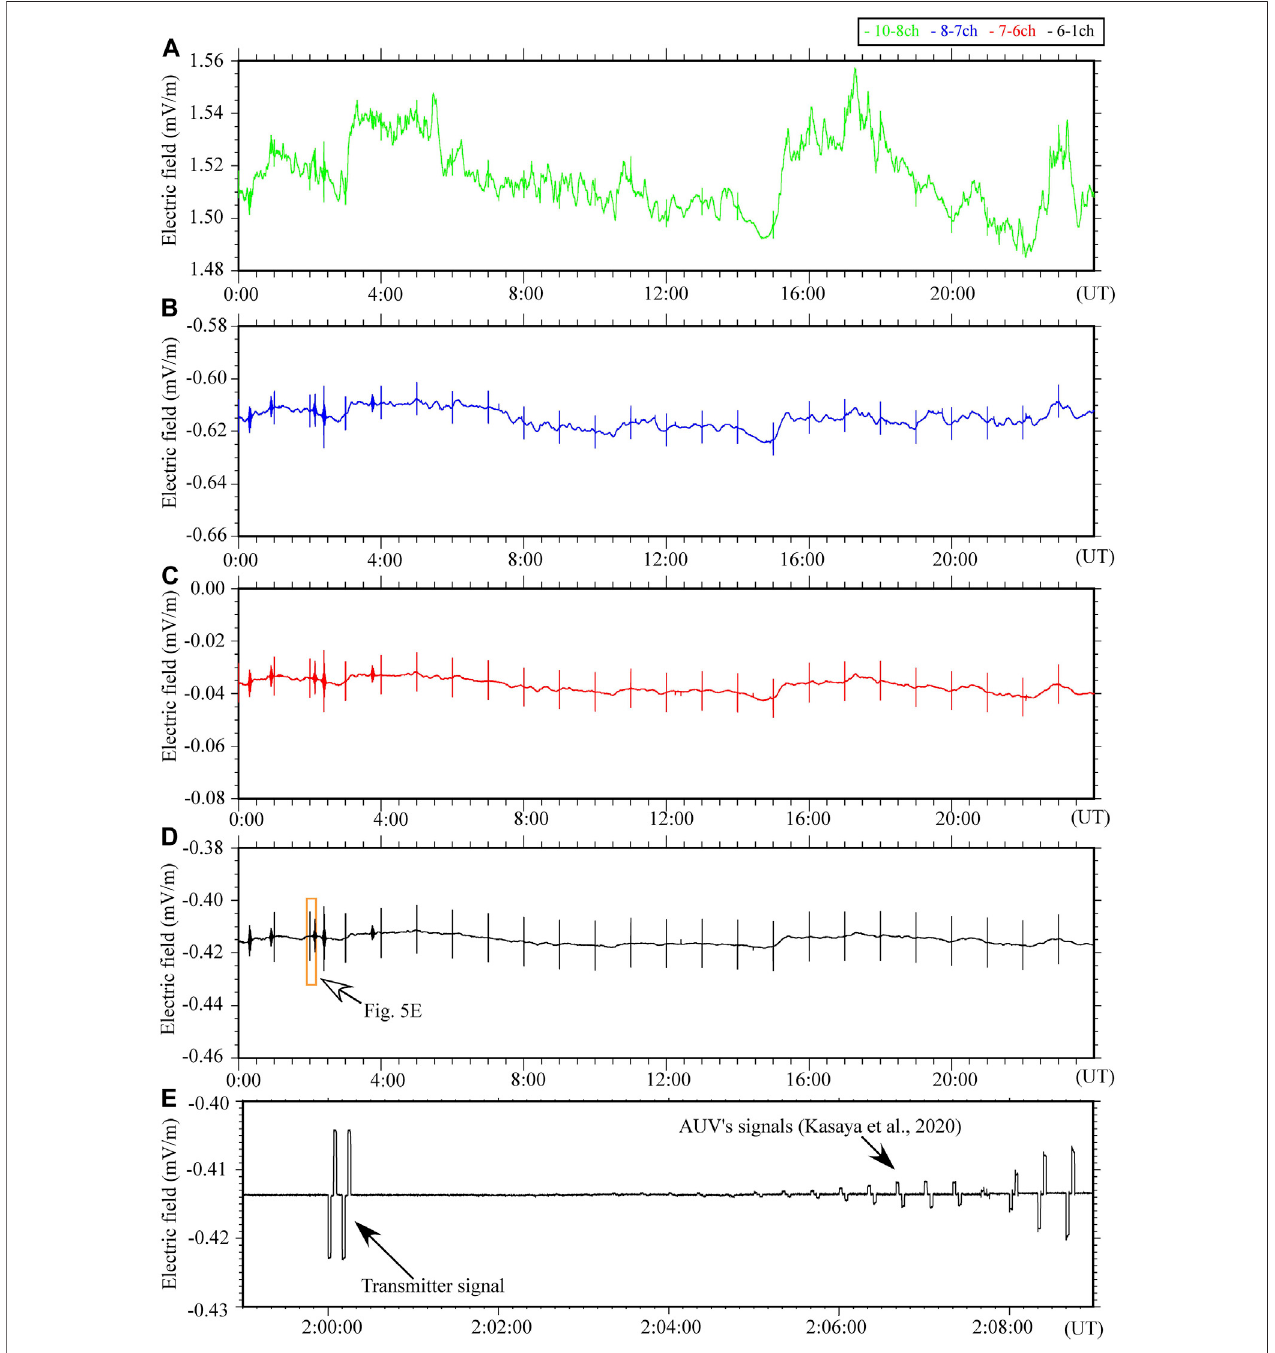
FIGURE 5 | (A – D) Time series of the electric fi eld calculated by four almost equally spaced electrode pairs on April 30, 2018. Locations of these electrodes are denoted byredsquaresin Figure 3A . (E) Enlarged (10 min)timeseriesobtainedthe electrode pair(ch. 6 – 1) recording theresponsesofrectangularwaveformsfrom the transmitter unit used for the present study and a transmitter loaded on an AUV during another survey (Kasaya et al., 2018; Kasaya et al., 2020).